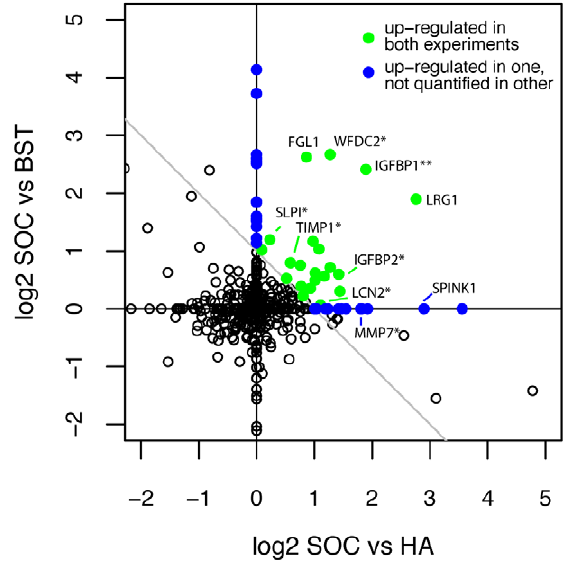
Figure 1. Log2 serum protein ratios from both IPAS experi- ments. Green points represent proteins up-regulated in both experiments. Blue points represent proteins up-regulated in one experiment and not observed in the other. *Benchmark marker validated by ELISA assay; **New marker validated by ELISA assay.